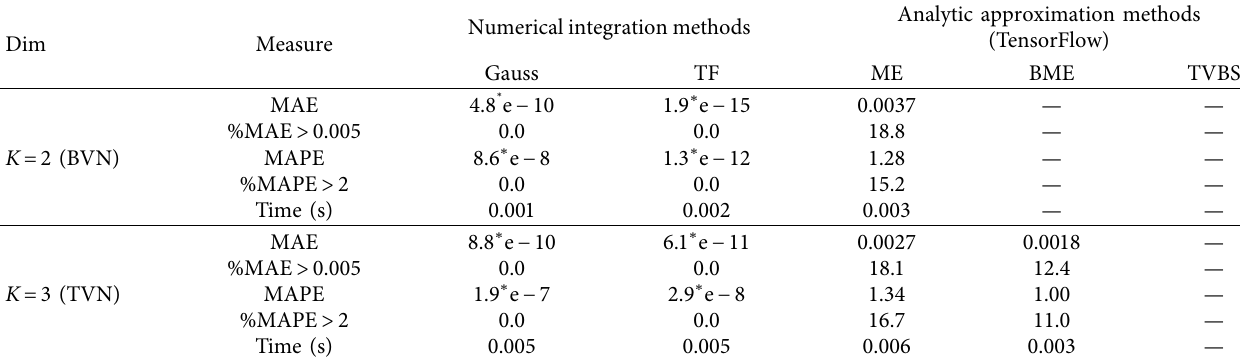
Table 1: BVN and TVN evaluation results for the different